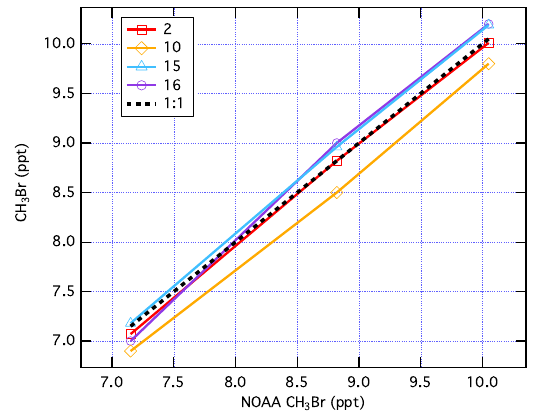
Fig. 7. Results from both diluted and undiluted samples for CH 3 Br for five laboratories plotted against NOAA results. Five CH 3 Br scales show a near-linear relationship over the range of mole frac- tions